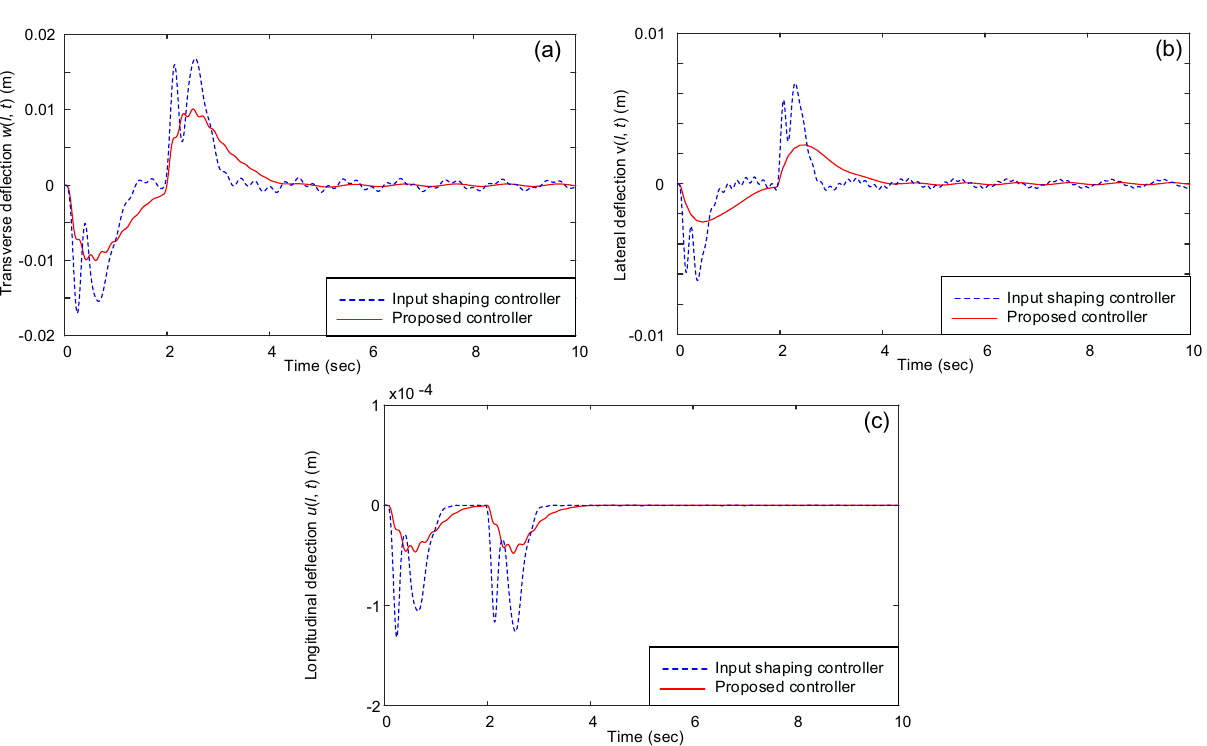
Figure 6. Vibrations of the beam’s tip under boundary disturbances: ( a ) Transverse vibration w ( l , t ), ( b ) lateral vibration v ( l , t ), and ( c ) longitudinal vibration u ( l , t